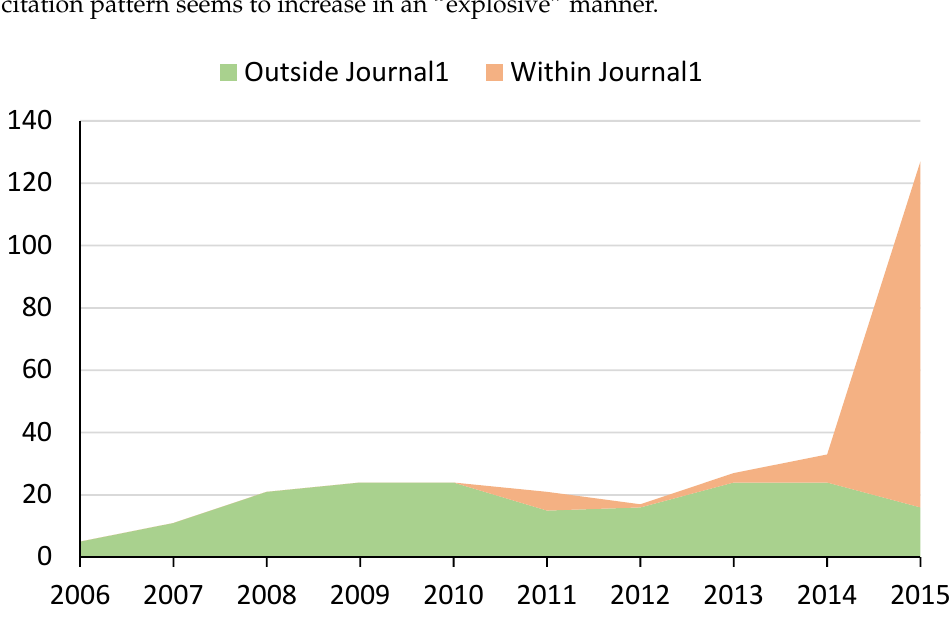
Figure 2. Citations of Author1’s papers in WoS distinguishing between citations of Author1’s papers, wherever published, whether cited or not in Journal1.